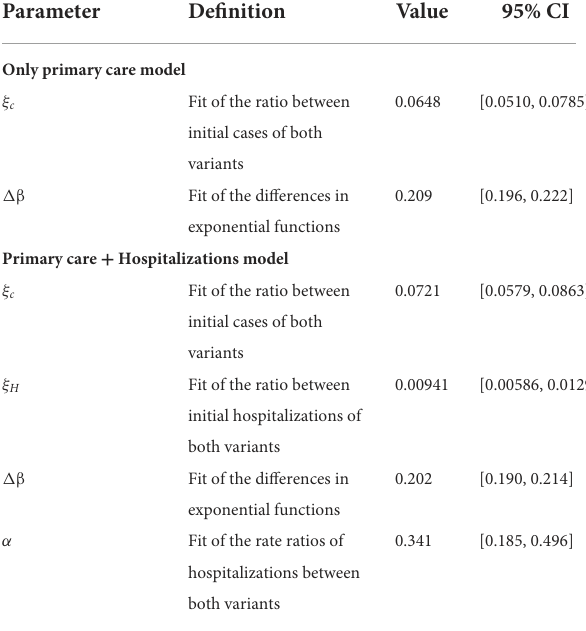
TABLE 4 Values of the parameters obtained from the fitting of the substitution model to primary care screened samples and to the joint fitting of primary care and hospital variants